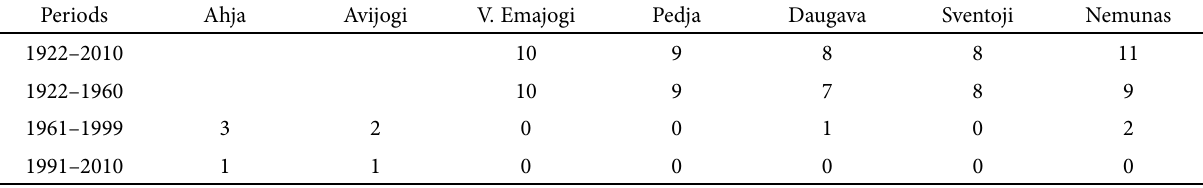
Table 4. Number of big spring floods (probability of ≤10%) in the rivers of continental (a), marine (b) and transitional type (c) a)